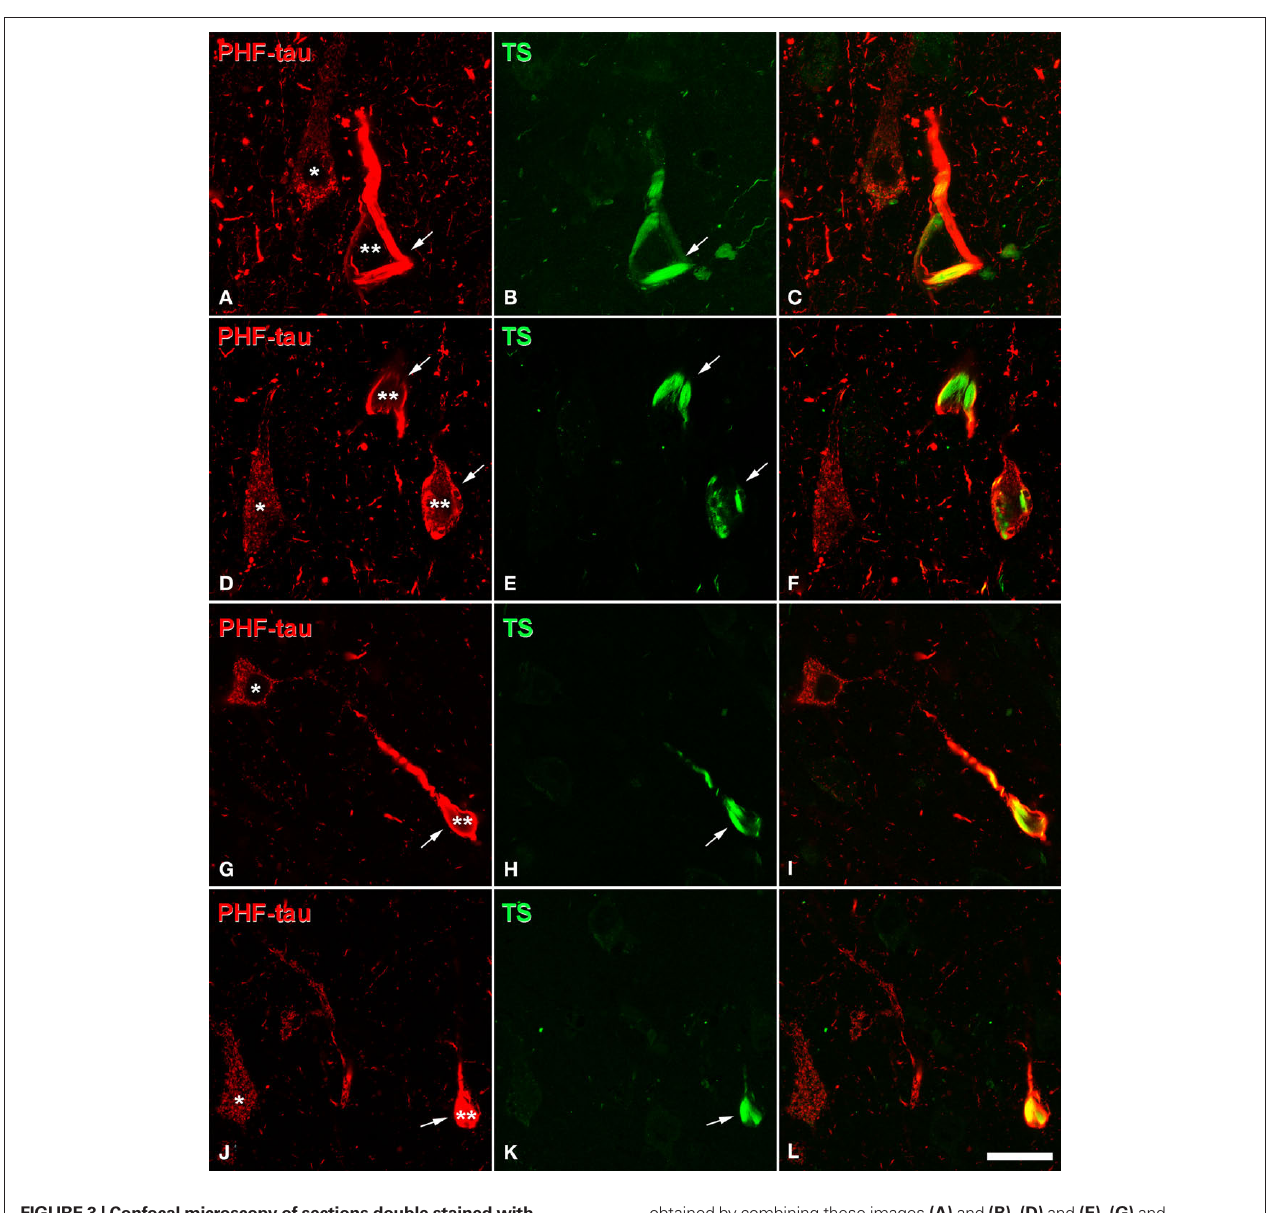
FiGure 3 | Confocal microscopy of sections double stained with an anti-PHF-tau antibody (red) and Thioflavine-S (TS, green), which labels PHF-tau forming NFT. (A,B) , (D,e) , (G,H), and (J,K) pairs of confocal images from the same section and field in the CA1 hippocampal region of AD patient P1, P7, P4, and P3, respectively. Panels (C , F,i,l) were